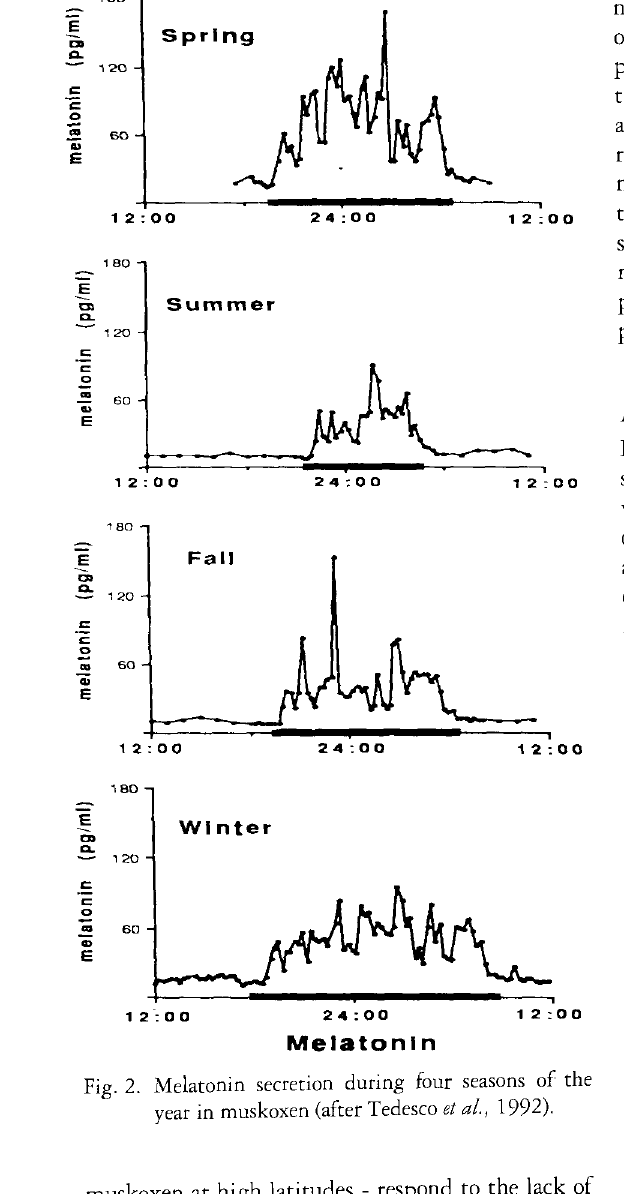
muskoxen at high latitudes - respond to the lack of photoperiodic information particularly in summer to accutately time reproduction. In some cases ani mals must begin breeding before they perceive a short day (due to the absence of melatonin secretion during summer), the classical cue to time of breed ing. The answer probably comes from a study in pinealectomised sheep, which were given infusions of melatonin representing different three month pottions of the year (Woodfill et al, 1994). This three month period of photoperiodic information each year was sufficient to synchronise the